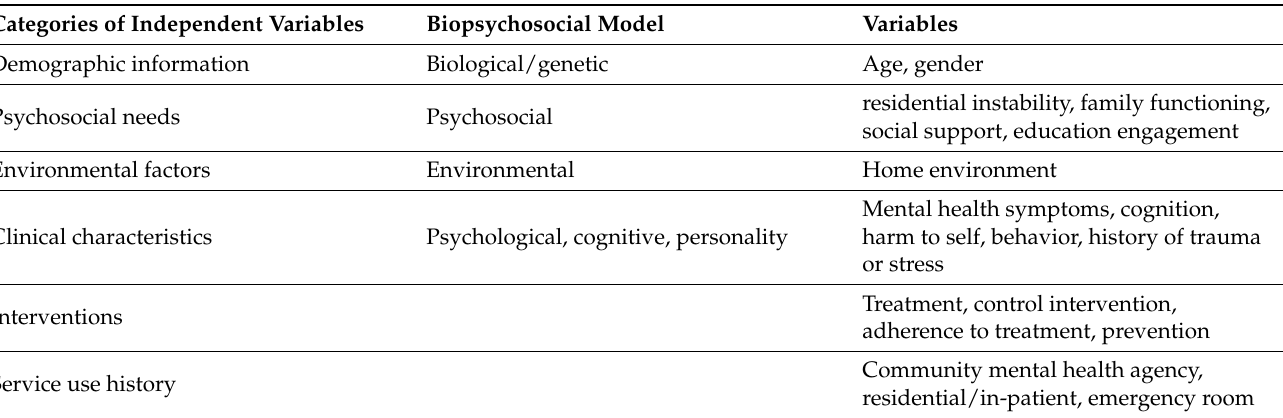
Table 1. Description of independent variables available from the interRAI ChYMH or ChYMH